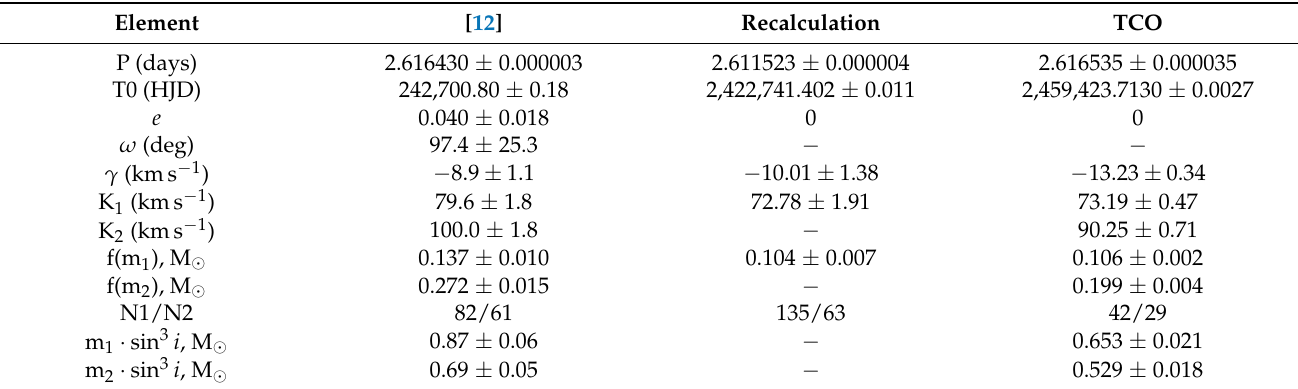
Table 3. Orbital elements derived for 2 Lacertae (HR